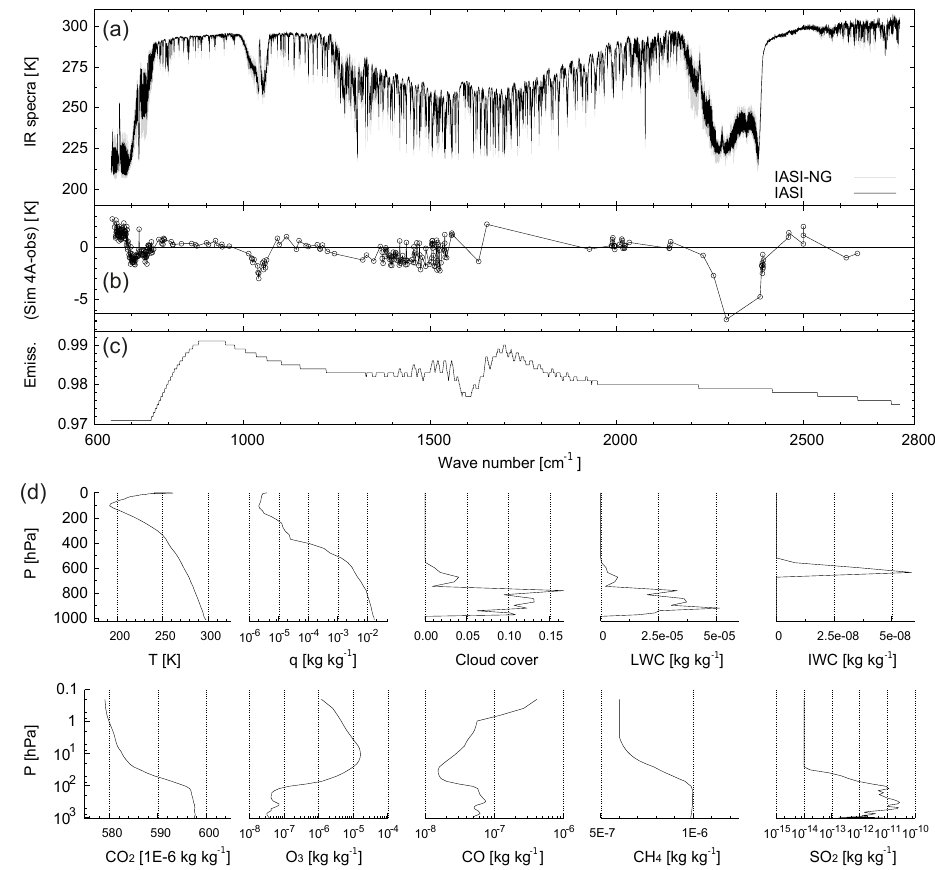
Figure 3. Example of the information for a single simulation corresponding to 3 February 2013 at 21:13:46: the IASI and IASI-NG simula- tions (a) , the differences between the 4A IASI simulations and the IASI observations (b) and the surface emissivity spectrum (c) . The bottom panel (d) displays the vertical profiles of temperature, specific humidity, cloud cover and hydrometeor contents (ice water content (IWC), liquid water content (LWC)) and atmospheric trace gases.